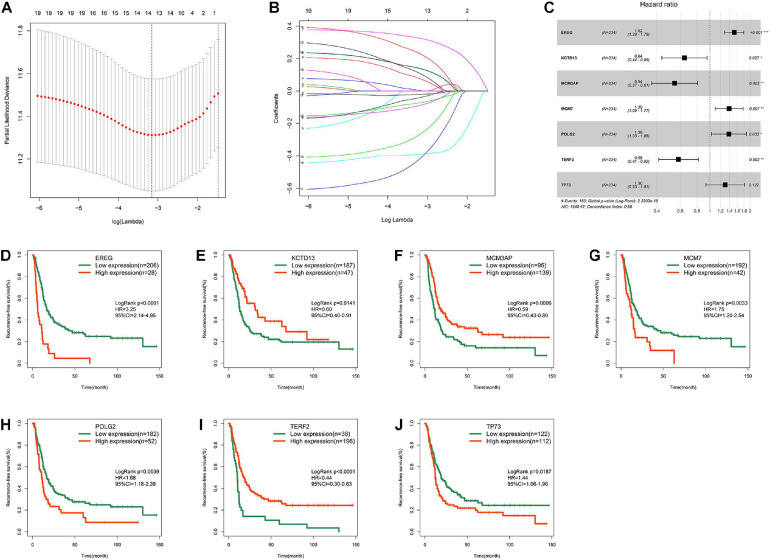
Development of the DNA replication-related signature. (A) Cross-validation for tuning parameter (lambda) screening in the LASSO regression model. (B) LASSO coefficient profiles of 20 prognostic DNA replication-related genes. (C) Forest plot of the seven DNA replication-related genes. (D) Survival cure for EREG. (E) Survival cure for KCTD13. (F) Survival cure for MCM3AP. (G) Survival cure for MCM7. (H) Survival cure for POLG2. (I) Survival cure for TERF2. (J) Survival cure for TP73. ∗p < 0.05; ∗∗p < 0.01; ∗∗∗p < 0.001.